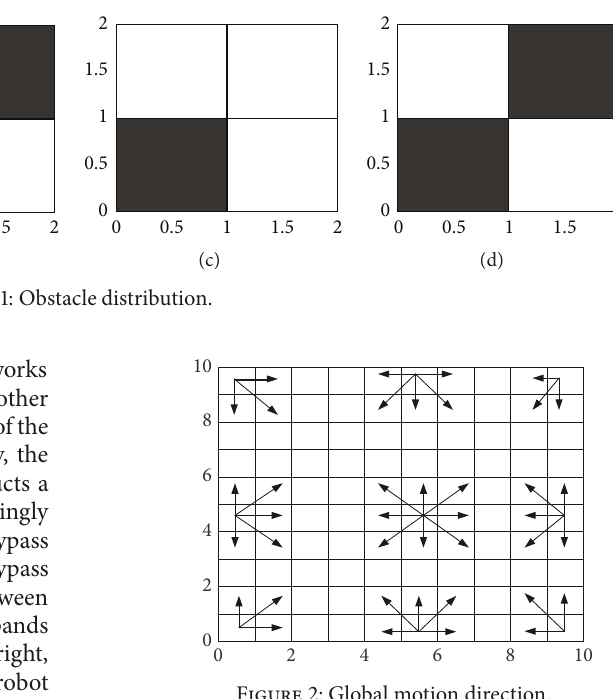
Figure 2: Global motion